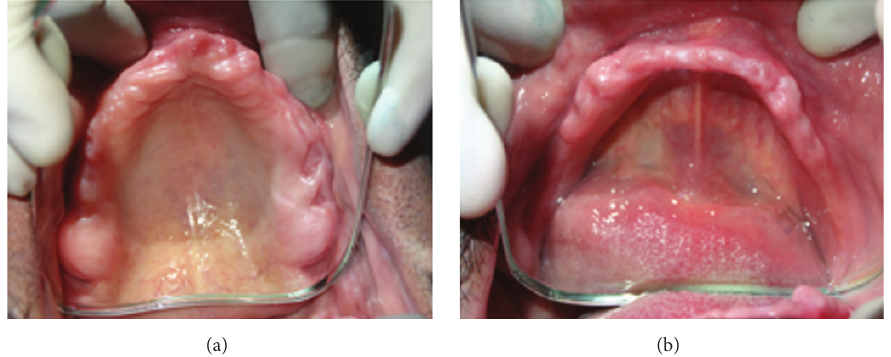
Figure 1: Unhealed maxillary and mandibular residual ridges with severe undercuts.